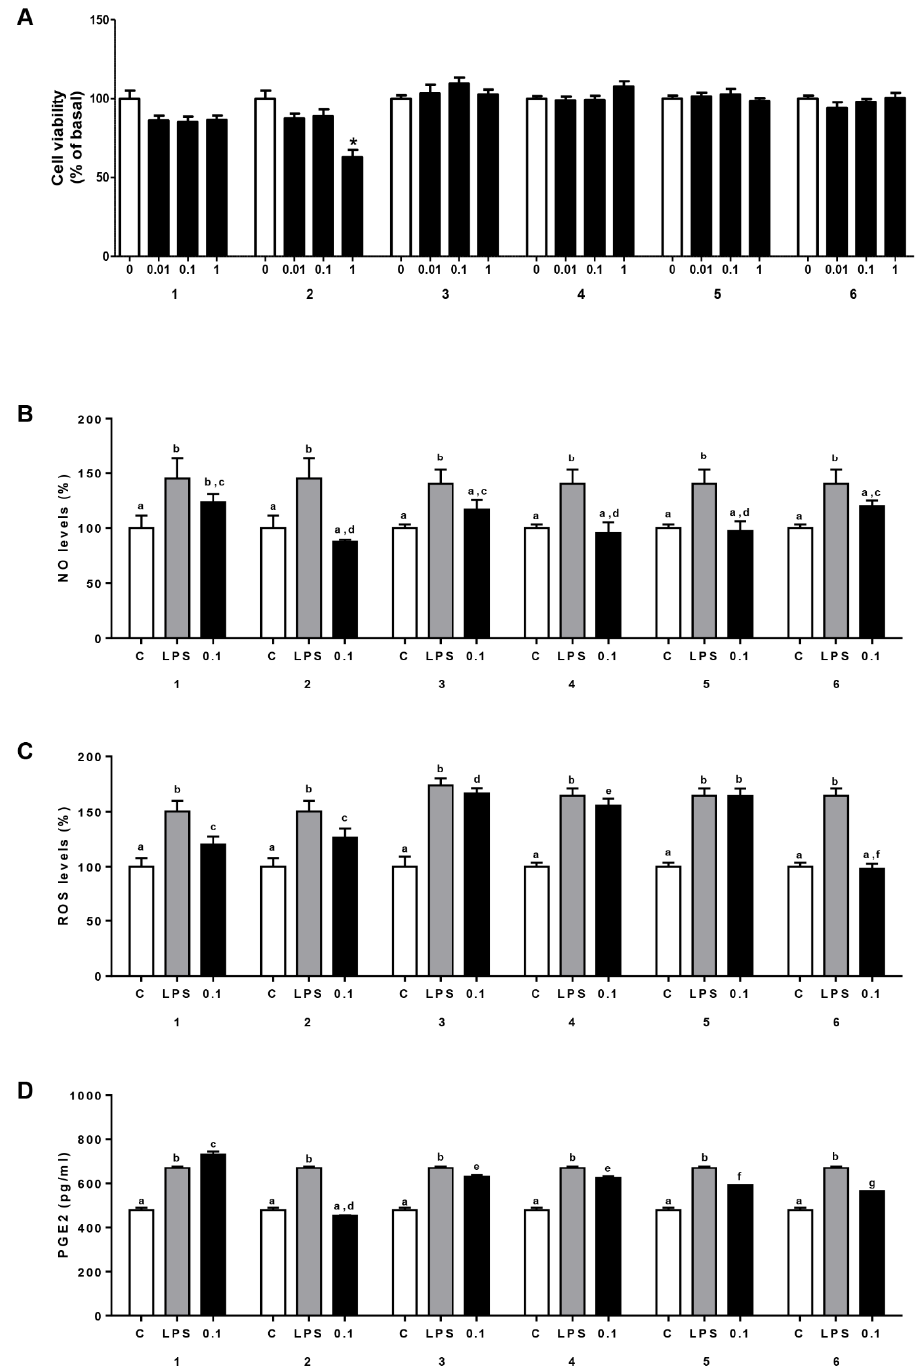
Figure 3. Effects of low doses of phenylacetamide RSV derivatives on U937 cell viability, NO and ROS levels, and PGE2 production. ( A ) U937 cells were treated with vehicle DMSO (0) or the pheny- lacetamide RSV derivatives ( 1 – 6 ) at the indicated concentrations (0.01, 0.1, or 1 µ M). Cell viability was assessed by MTT assay after 72 h exposure. Results are expressed as mean ± SE of three separate experiments (* p < 0.05 with respect to control (0)). ( B – D ) In PMA-treated U937 cells, unstimulated (C) or activated with LPS alone (LPS), or in the presence of 0.1 µ M of the phenylacetamide RSV derivatives ( 1 – 6 ), NO ( B ), ROS ( C ) and PGE2 ( D ) levels were quantified. Means ± SE of four inde- pendent experiments are shown. In ( B – D ), different letters indicate significant differences between treatments at p < 0.05 (Tukey’s post hoc